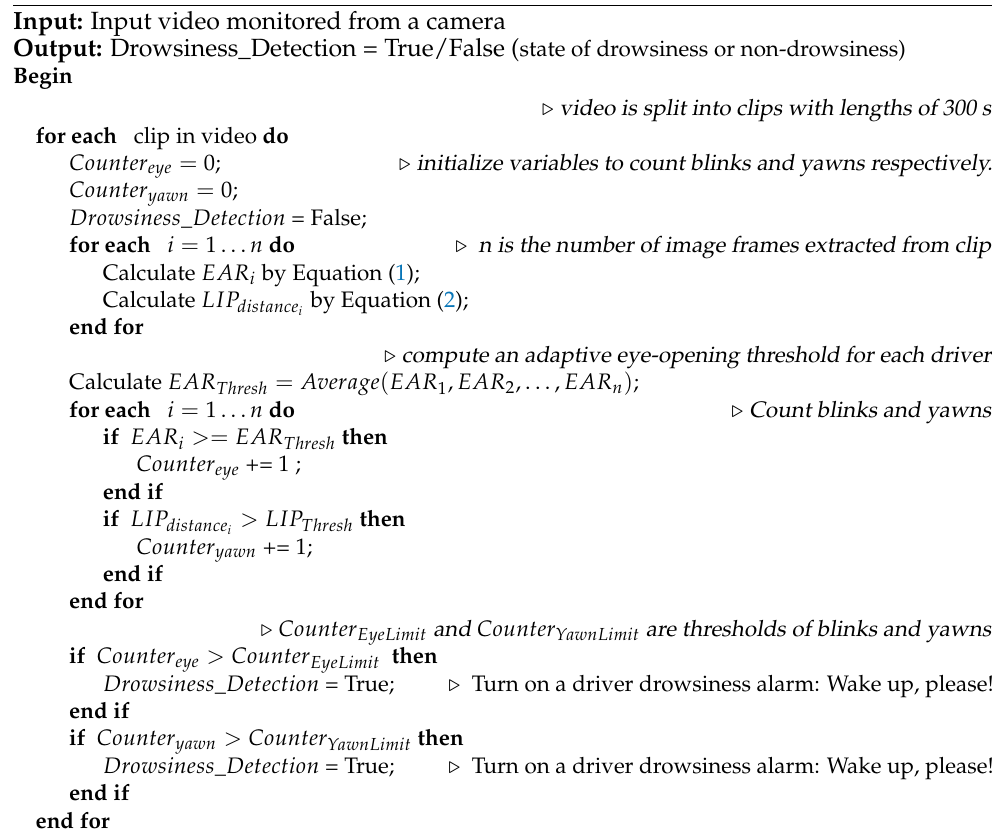
Algorithm 1 Drowsiness Detection and Prediction